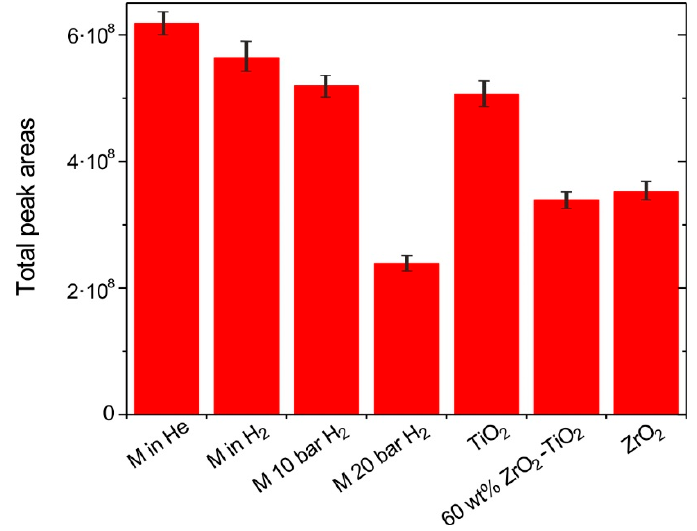
ff ects on the overall Figure 3. The H 2 and catalyst effects on the overall yields. Figure 3. The H 2 and catalyst e